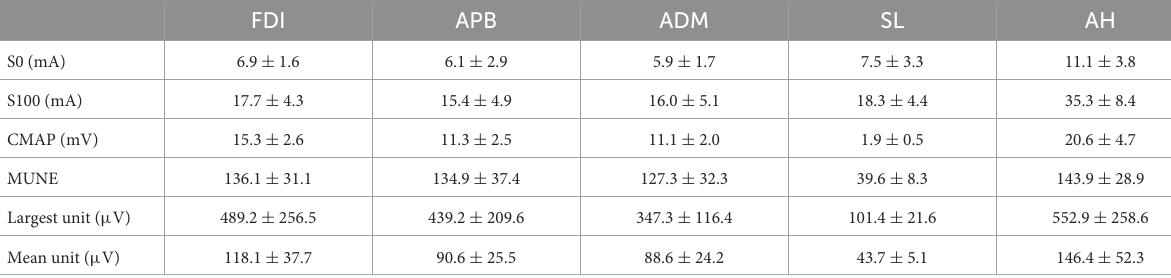
TABLE 1 CMAP scan analysis of 5 muscles (mean ± standard deviation).